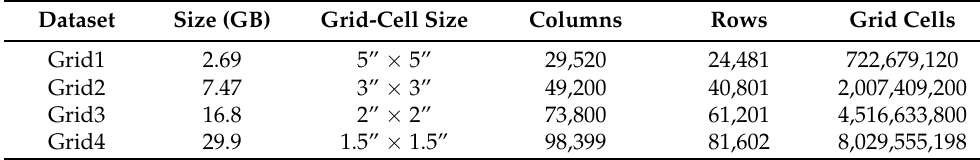
Table 2. Australian elevation